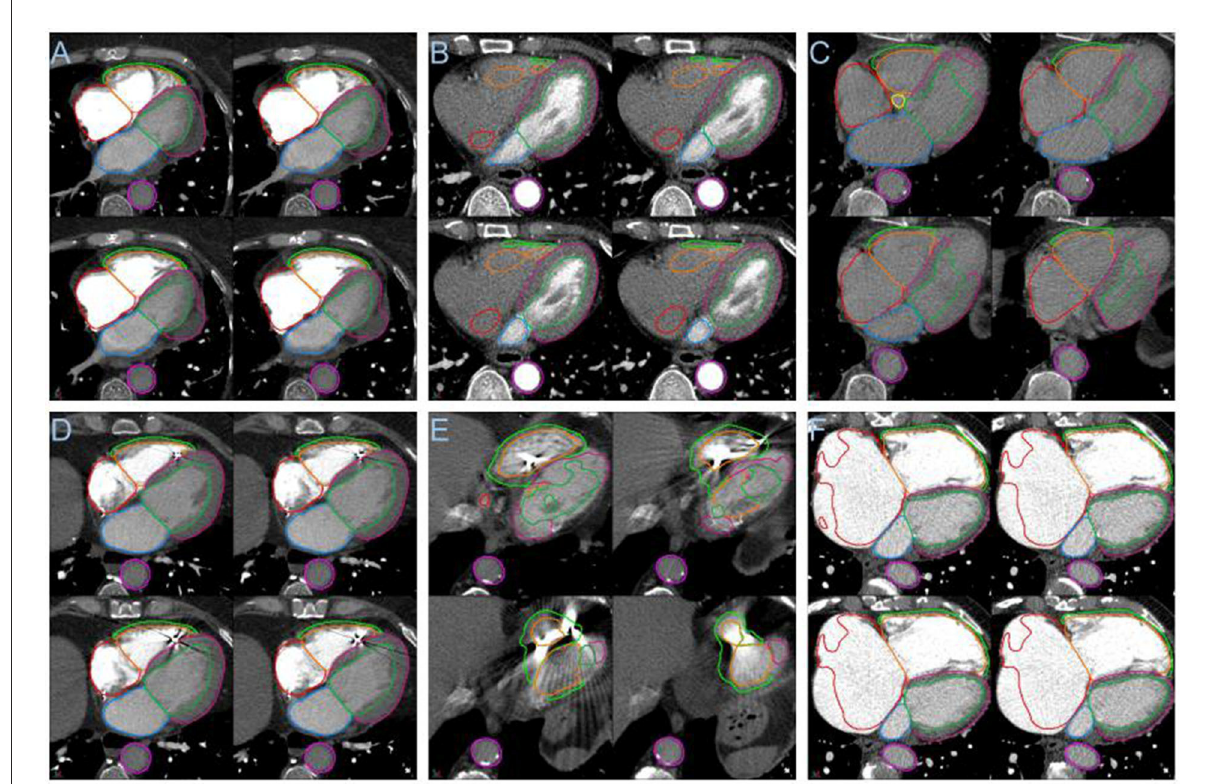
FIGURE8 (A) Segmentation failure in the LV myocardium in the presence of pericardial effusion. (B) Failure of segmentation of right sided cardiac structures with poor right sided contrast opacification. (C) Segmentation failure apically with globally poor contrast opacification. (D) Example showing success in the presence of an intracardiac device. (E) Segmentation failure in the region of an intracardiac device. (F) Failure in right atrial segmentation with severe